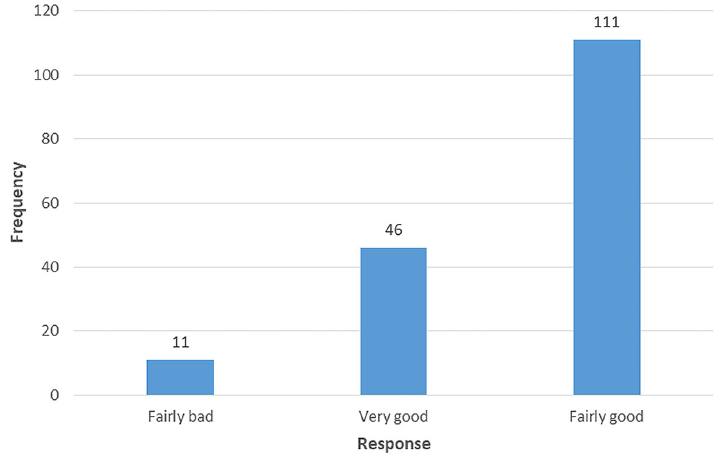
Figure 1. Response on “ During the past month, how would you rate your sleep quality overall? ” .